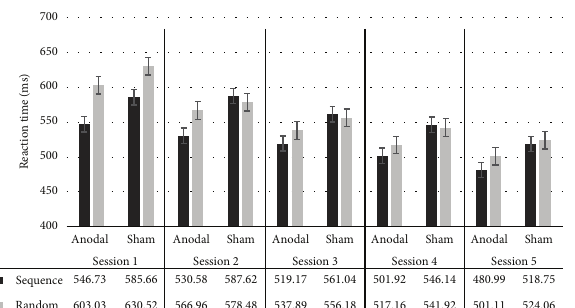
Figure 2: Mean RT sequence and random blocks (ms) per group and per